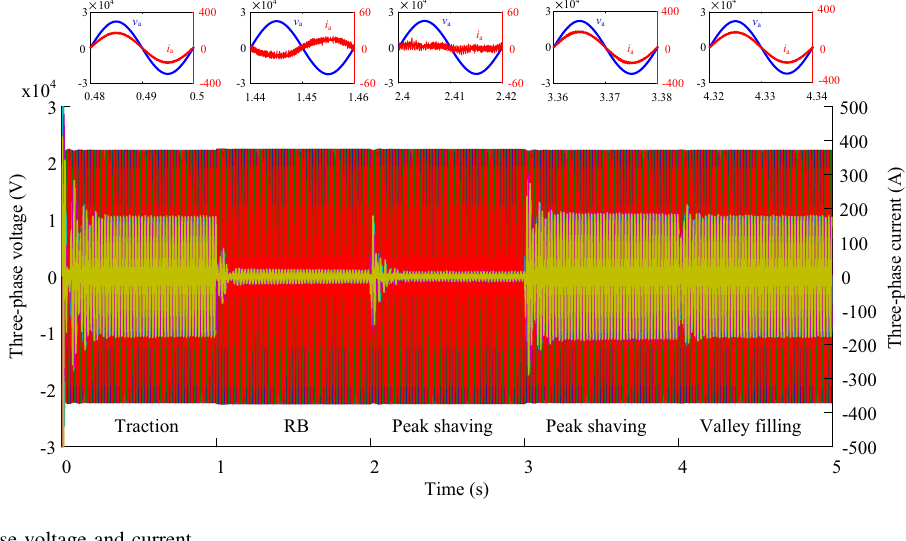
Fig. 13 Three-phase voltage and